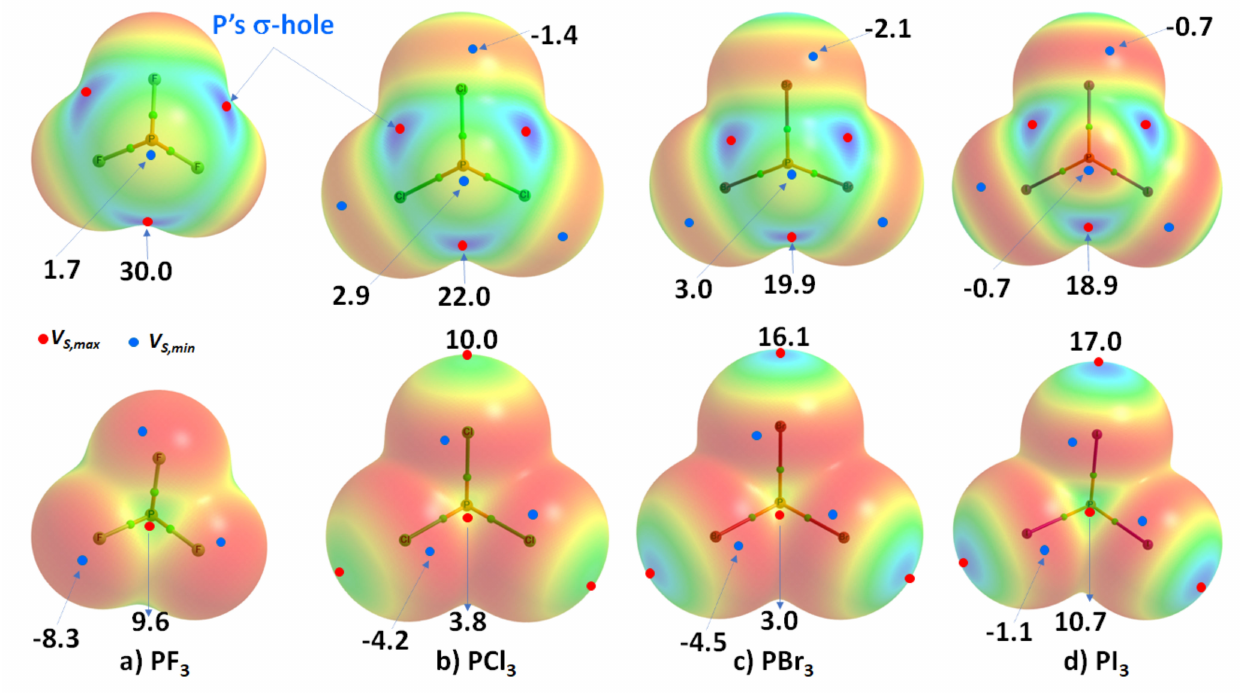
Figure 3. Comparison of ω B97XD/Jorge-ATZP calculated 0.001 a.u. isodensity envelope mapped potential on the electrostatic surfaces of PX 3 (X = ( a ) F, ( b ) Cl, ( c ) Br, ( d ) I) molecules. Selected tiny circles in red and blue describing V S,max and V S,min values in kcal mol − 1 are shown, which are the local maxima and minima of potential, respectively. Two views of each MESP graph are displayed for each molecule. Top: coordinated P faces the reader. Bottom: the three X atoms forming a triangular architecture face the reader. The QTAIM-based molecular graphs are superimposed on each case, and the bond paths are in atom color, accompanied by bond critical points (tiny sphere in